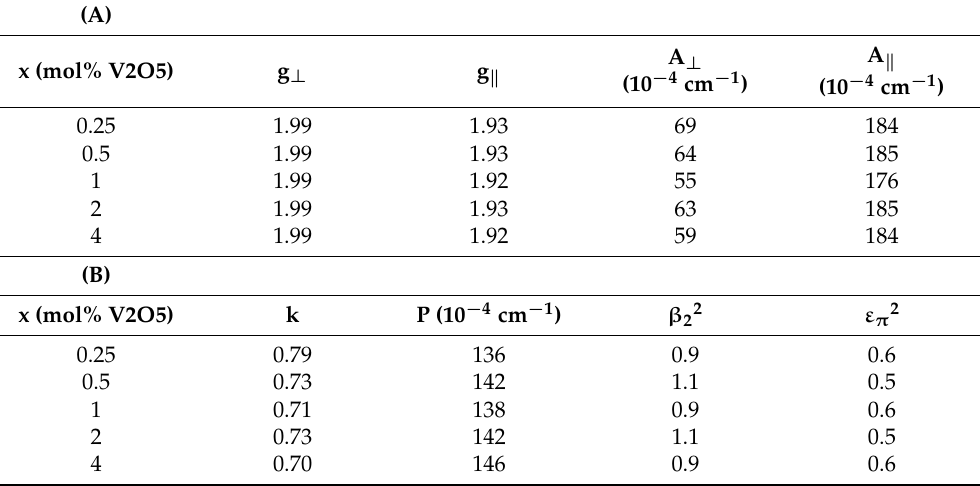
Table 2. ( A ). EPR parameter and MO coefficients for a xV 2 O 5 · (100 − x) [CaF 2 · 3P 2 O 5 · CaO] glass system with 0 ≤ x ≤ 4 mol%. ( B ) . MO coefficients for a xV 2 O 5 · (100 − x) [CaF 2 · 3P 2 O 5 · CaO] glass system with 0 ≤ x ≤ 4